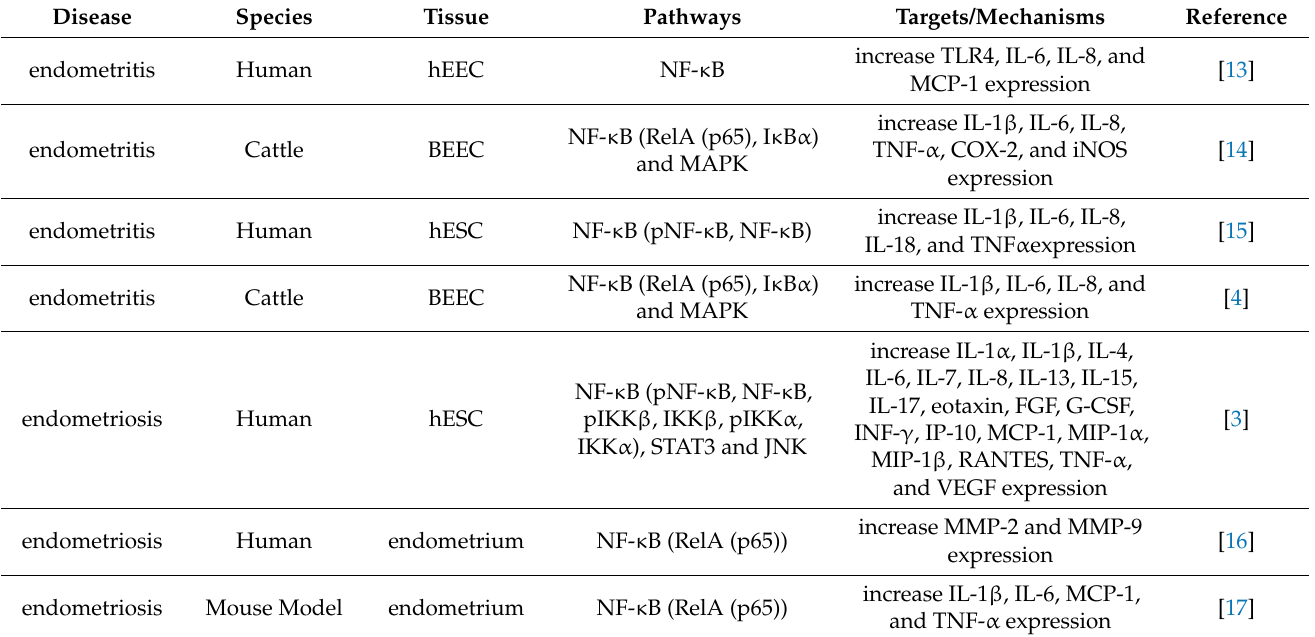
Table 1. The selected recent research on pathways, targets, and mechanisms of the most common endometrial diseases (endometritis, endometriosis, endometrosis, and endometrial carcinoma) was carried out on humans and animals (cattle, mouse, and horse) specimens. Disease